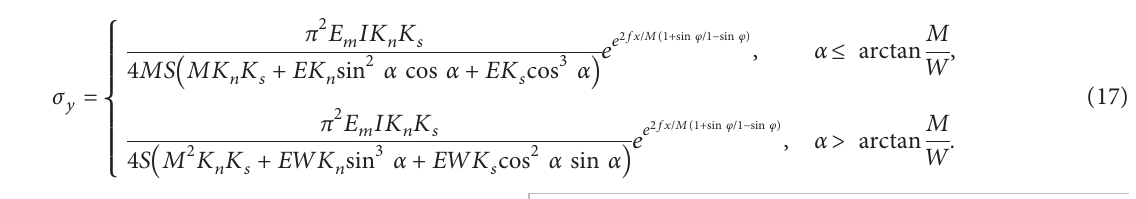
Figure 10: Vertical stress on working face. (a) The influence of the mining height ( E coal ( M �